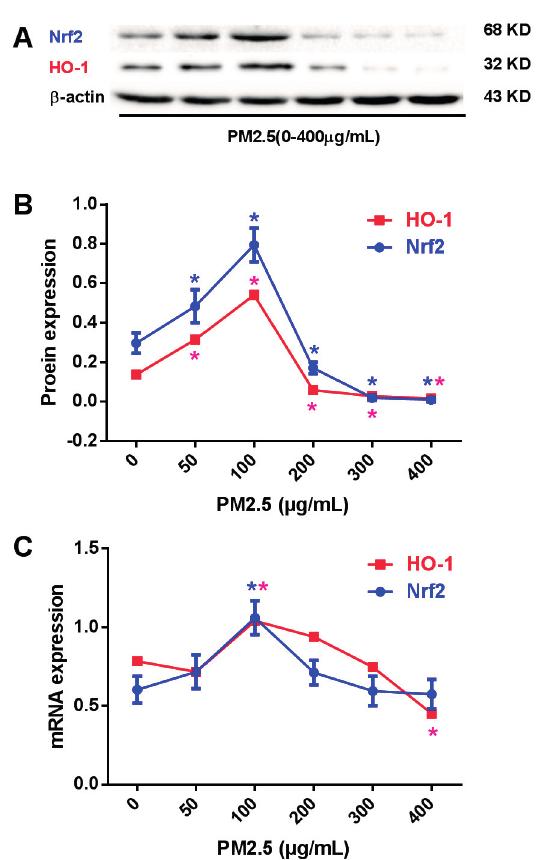
Figure 4. Nrf2 and HO-1 expression in PM 2.5 -treated HUVECs. ( A ) Representative images of the expression of Nrf2 and HO-1 in HUVECs treated with 0–400 μ g/mL PM 2.5 for 24 h. ( B ) Pooled data of Nrf2 and HO-1 protein expression in HUVECs. ( C ) Pooled data of Nrf2 and HO-1 mRNA expression in HUVECs. Data are expressed as the means ± SEM of three independent experiments. * p < 0.05 vs. HUVECs incubated without PM 2.5